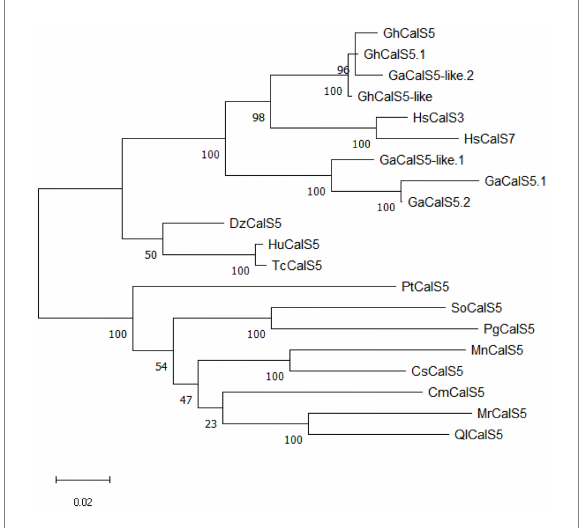
FIGURE 1 Phylogenetic analysis of GhCalS5 protein and CalS proteins of other plant species. The phylogenetic tree was constructed by the maximum likehood method using MEGA11 software. The accession numbers of sequence data were as follows: GhCalS5.1 , Gossypium hirsutum CalS5.1 [XP_016676296.2]; GaCalS5.1 , Gossypium arboreum CalS5.1 [KHG21671.1]; GaCalS5-like.1 , Gossypium austral CalS5-like.1 [KAA3479749.1]; GaCalS5.2 ,